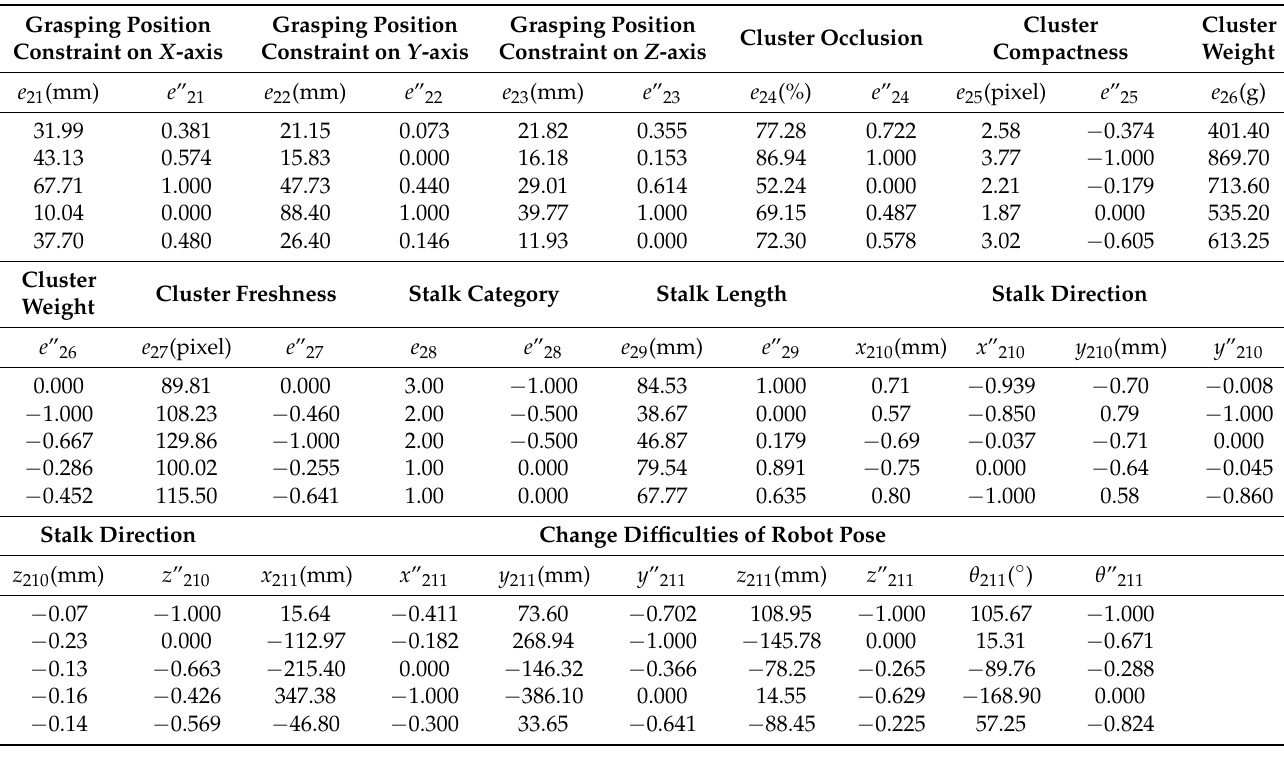
Table 2. Experimental data with main differences of fruit cluster features.